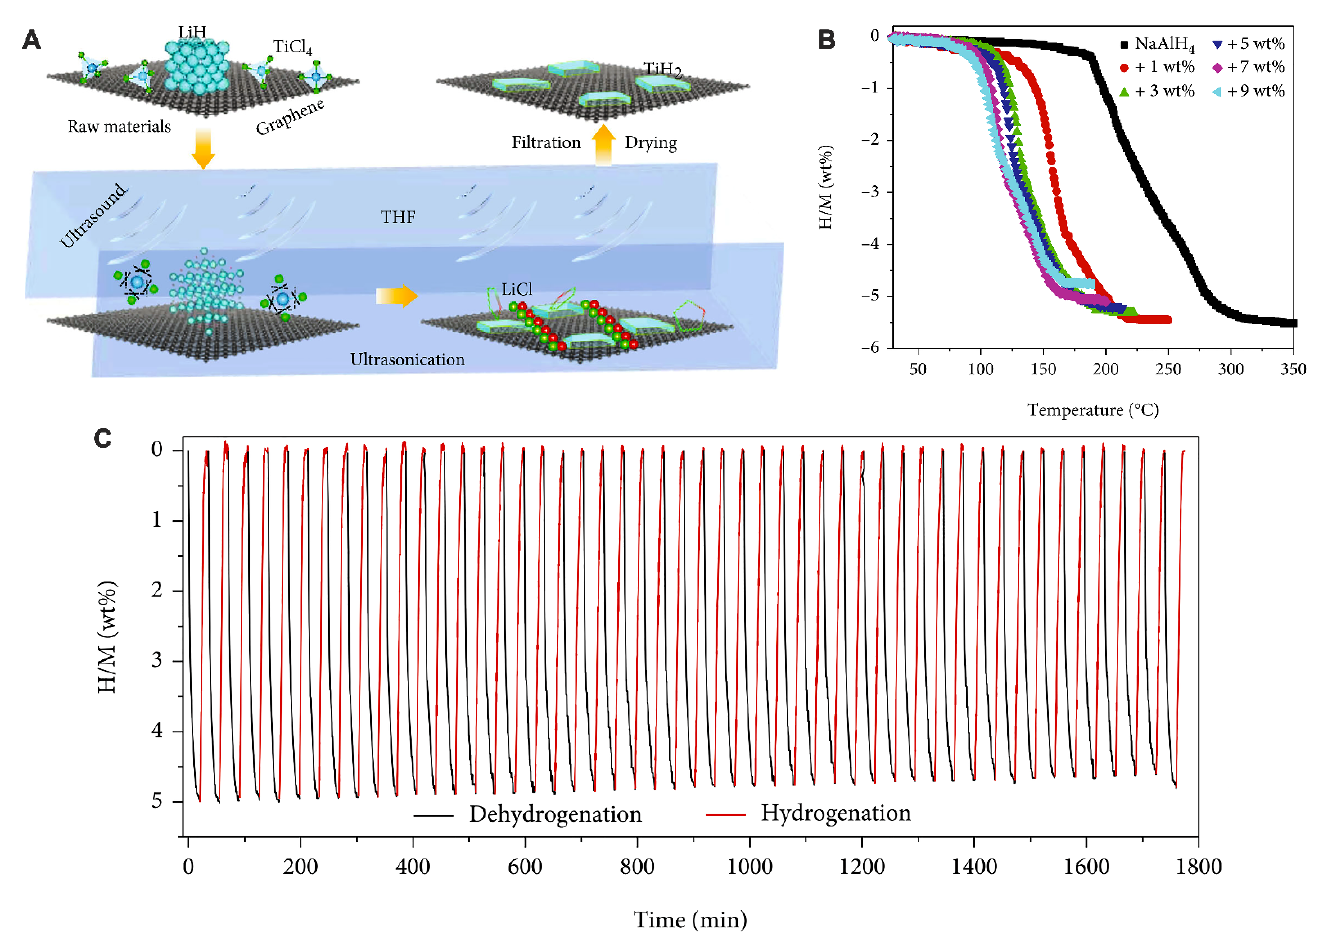
Figure 8. ( A ). Schematic illustration for the preparation process of TiH 2 nanoplates.; ( B ) Volumetric release curves of NaAlH 4 doped with NP-TiH 2 @G, ( C ). Cycling tests operated at 140 °C for